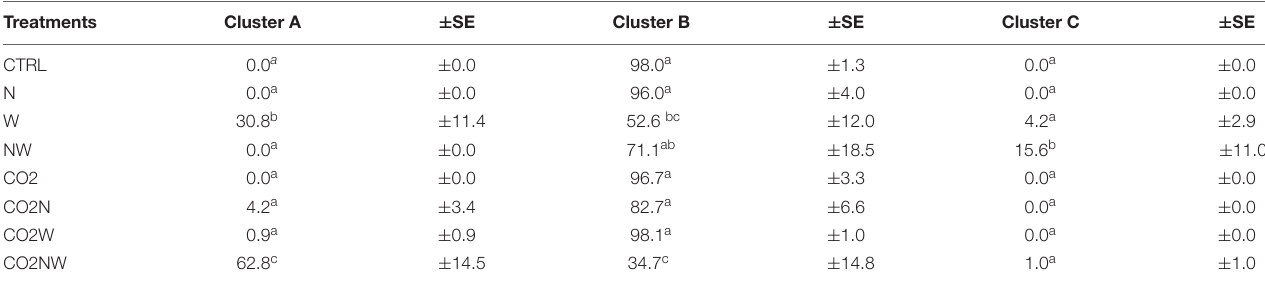
Meanvaluesarepresentedwiththecorrespondingstandarderrors.TreatmenteffectwassignificantforNitrobacterfromclusterAaffiliatedtoN.hamburgensis(p < 0.0001) and for Nitrobacter from cluster B not affiliated to any cultivated strain (p = 0.0003), and marginally significant for cluster C (p = 0.06). For each cluster, different letters indicate significant difference between treatments (p < 0.05).